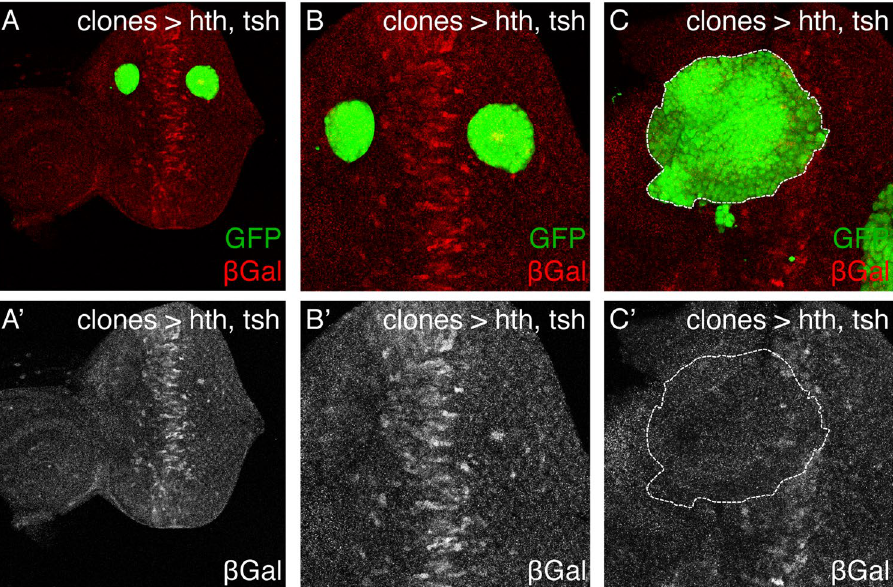
Figure 3. Co-expression of hth + tsh downregulate EcR signaling. hth + tsh-expressing clones (marked with GFP) induced in an Ecdysone Response Element- lacZ (EcRE-Z) background analyzed in L3 eye discs. lacZ expression is monitored with an anti- β galactosidase antibody ( β gal). EcRE-Z is expressed straddling the morphogenetic furrow (dashed line) exclusively ( A , A’ ). hth + tsh-clones overlapping the EcRE-Z domain repress its expression ( B ), while clones elsewhere do not ( A , A’ ). ( A ) is a lower magnification view of the disc shown in ( A’ ) where the whole pattern of EcRE-Z can be seen. The EcRE-Z sinla is shown separately in the lower